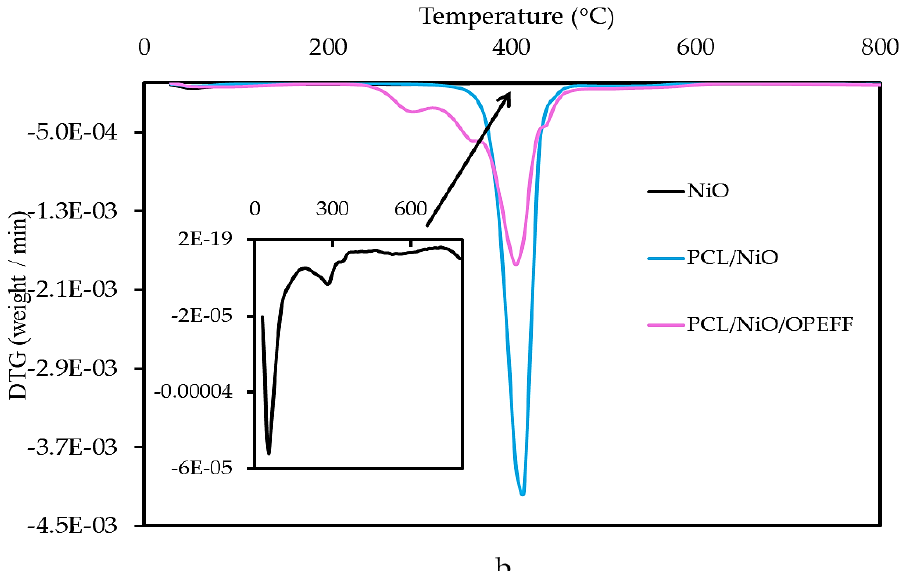
Figure 6. Derivative thermogravimetric (DTG) thermograms of ( a ) neat PCL, neat OPEFF, and PCL/OPEFF composite, and ( b ) Neat NiO, PCL/NiO, and PCL/NiO/OPEFF composite.